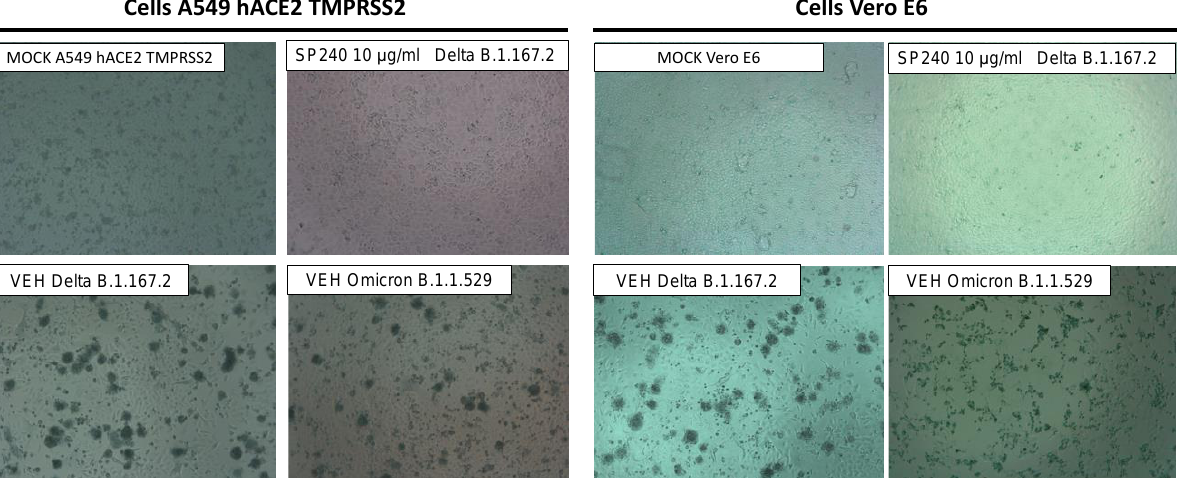
Figure 3. Prevention of Cytopathic Effects (CPE) in cells A549-hACE2-TMPRSS2 and Vero E6. The presence of CPE was monitored under an inverted light microscope EVOS. Displayed pictures indicate the cell’s viability after 48 h of the assay. In vehicle cells (VEH), no treatment with VNAR SP240 was reproduced. The CPE triggered by the infection of SARS-CoV-2 variants Delta (B.1.167.2) and Omicron (B.1.1.529) are shown in VEH pictures. Mock cells are not treated cells or without infection. Cells treated with 10 μ g/mL of VNAR SP240 were compared to the vehicle and mock cells to exclude the presence of CPE.